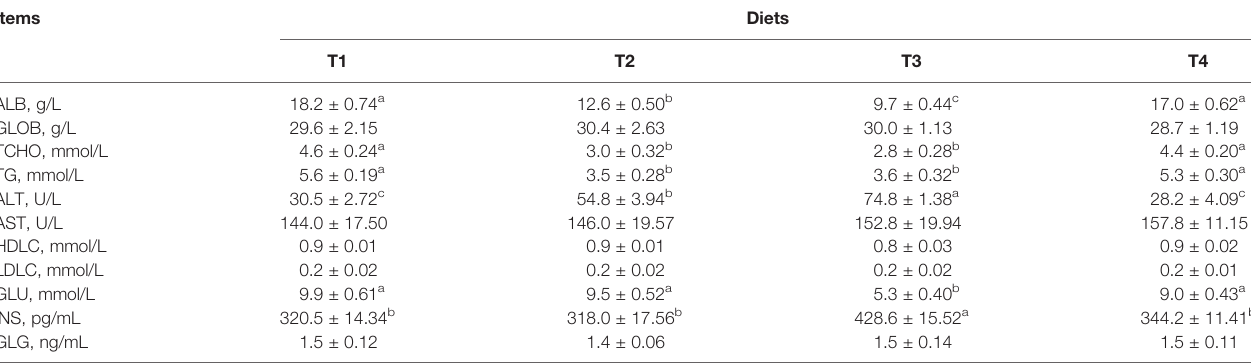
TABLE 2 | Serum metabolites of L. maculatus fed experimental diets.